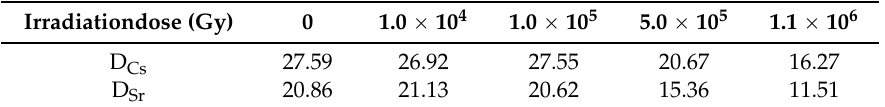
Table 6. The effect of irradiated extraction system on D Cs and D Sr